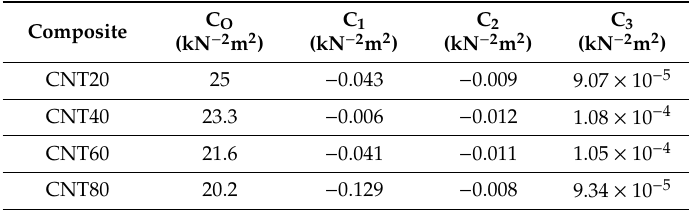
Table 2. Values of intercept C O and the fitting parameters C 1 , C 2 , and C